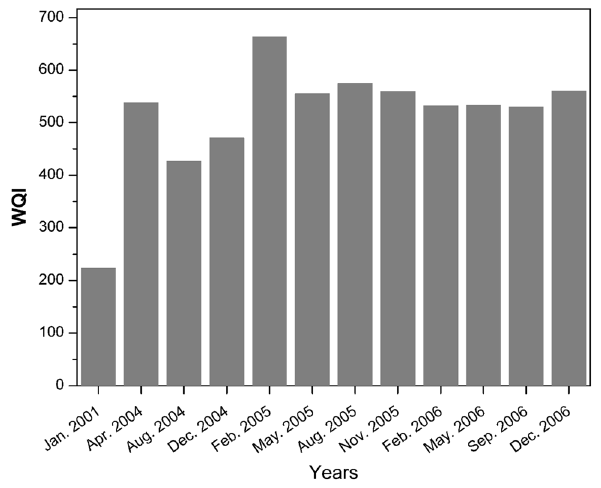
Fig. 5 Trend of WQI “station of